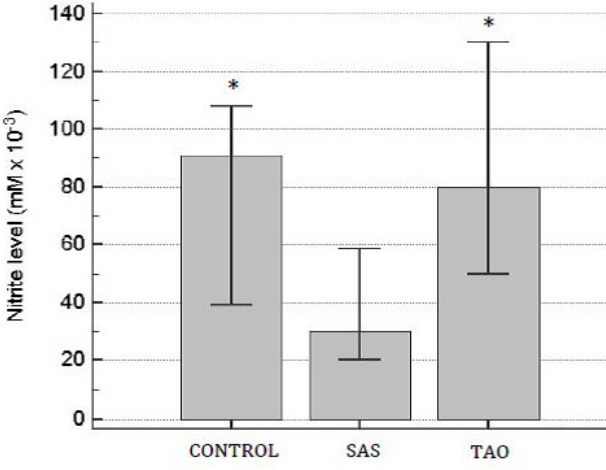
Fig. 3 - Superoxide dismutase (SOD) activity on human aortas of patients with severe aortoiliac occlusive stenosis (SAS) and with total aortoiliac occlusion (TAO). Values are expressed in mean and the brackets represent interval of confidence of 95%. ANOVA followed test t. *P<0.05 when compared to control group.